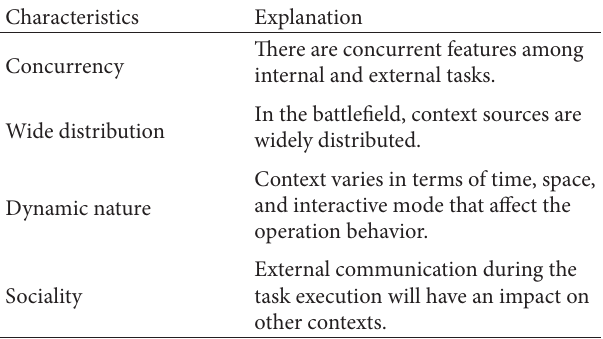
Table 3: Characteristics of PT’s